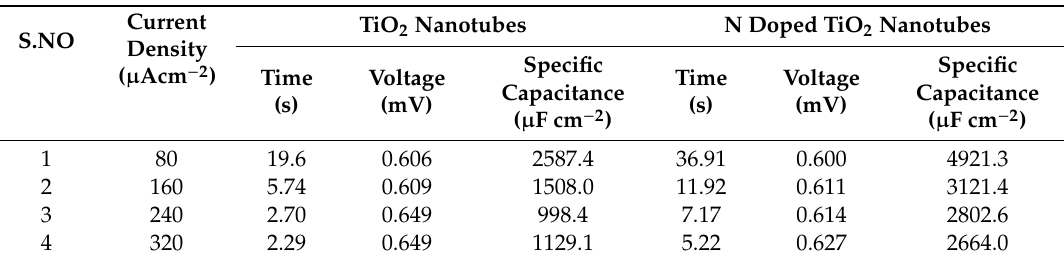
Figure 7. Galvanostatic first charge / discharge curves of TiO 2 nanotubes and N-TiO 2 nanotubes. Table 2. Comparative electrochemical performance of undoped TiO 2 - and N-doped TiO 2